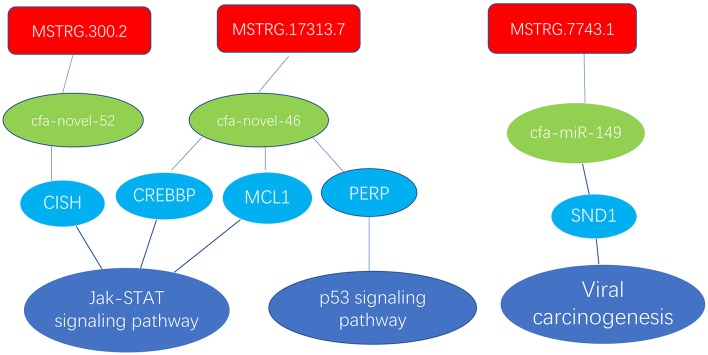
Enrichment of mRNAs in the Jak-STAT signaling pathway, p53 signaling pathway and viral carcinogenesis regulation network; lncRNAs are depicted in red, green represents miRNAs, and blue represents mRNAs.